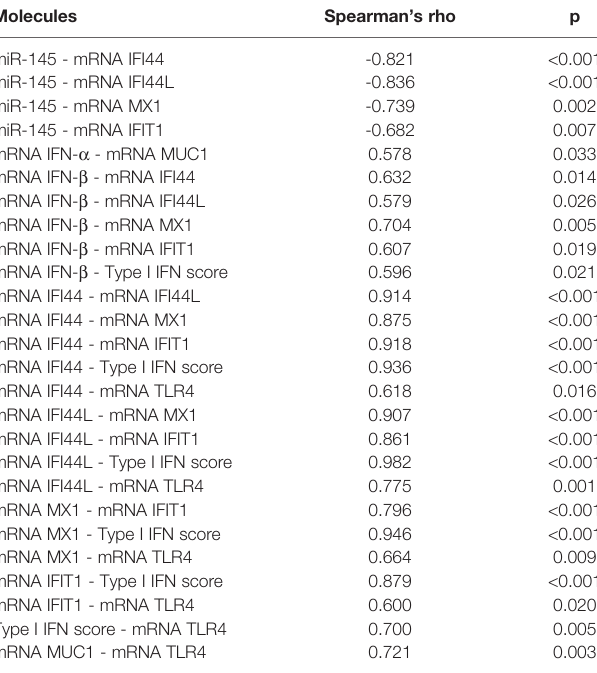
TABLE 2 | Spearman ’ s rank correlation coef fi cients between hsa-miR-145-5p levels, ISGs mRNA levels and clinical parameters of SS-patients and control subjects. Parameters